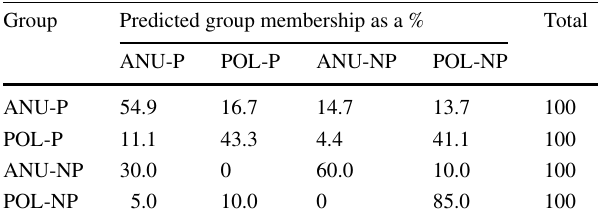
Table 9 Sampling classification results based on discriminant analy- sis (DA) for primary data